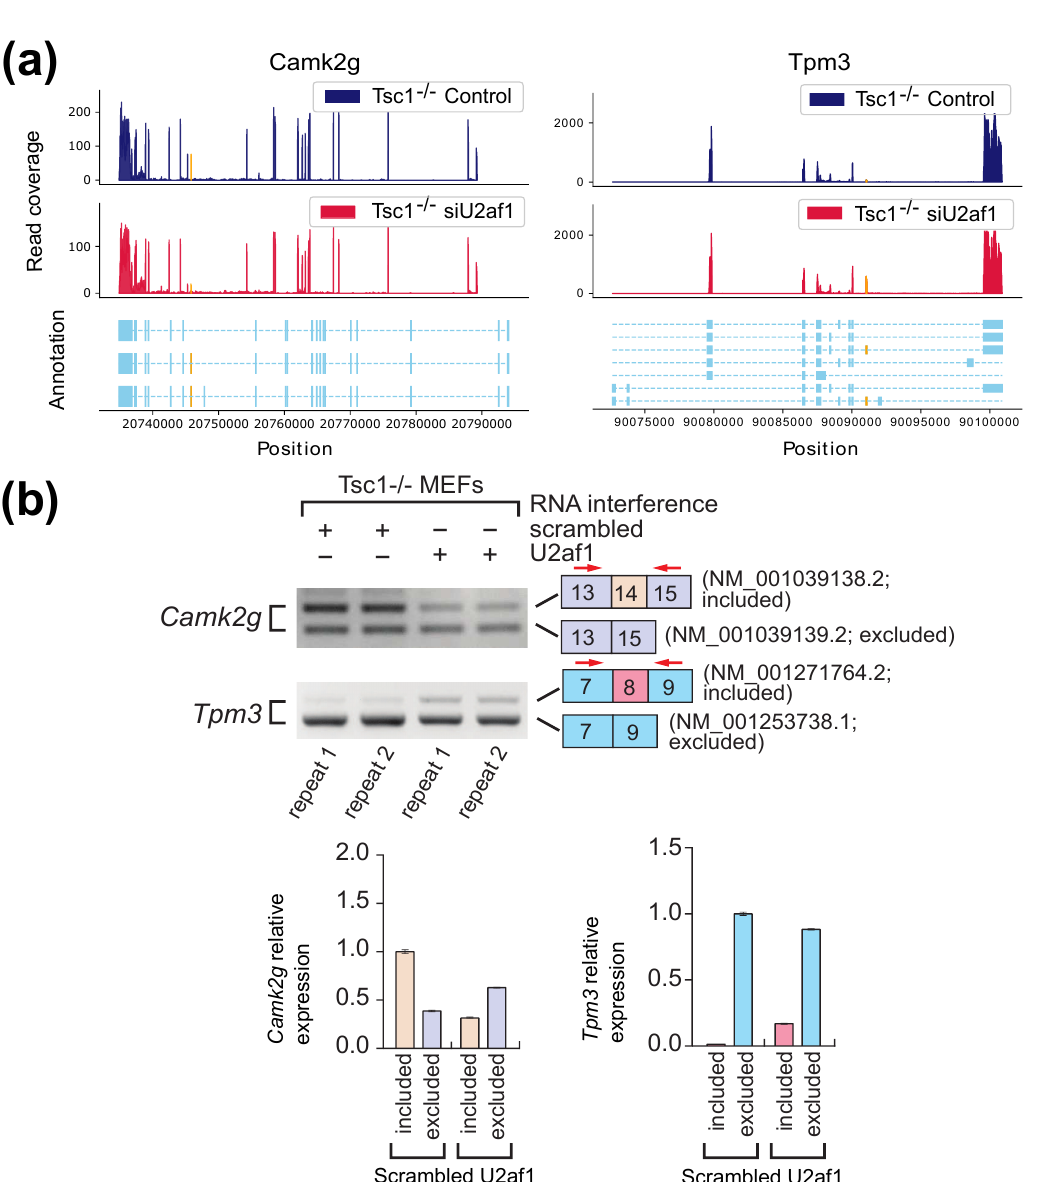
Figure 5. Validation of U2AF1-mediated alternative splicing events that are only detected by AS-Quant ( Camk2g ) or by AS-Quant and SUPPA2 ( Tpm3 ). ( a ) Isoform structures of Camk2g and Tpm3 gene and their RNA-seq read coverage plots. Alternatively spliced exons are marked in yellow. ( b ) Validation of isoform expressions was conducted using RT-PCR and agarose gel electrophoresis. Quantitation of gel images was done using ImageQuant software. Two biological repeats of experiment were performed. Exon inclusion and exclusion are color-coded. Total RNAs from Tsc 1 − / − MEFs used for RNA-Seq experiments were used for RT-PCR amplification of Camk2g or Tpm3 transcript isoforms. Scrambled RNA interference is control and U2af1 RNA interference is the case. The PCR primers to detect transcript isoforms for Camk2g or Tpm3 were marked by red arrows and their sequences are reported in the Supplementary document. Schematic of alternative spliced isoform structures for each PCR product is shown next to the gel image. Exon numbers and transcript identification numbers in RefSeq annotation are shown. A higher band intensity of PCR products indicates a higher expression of that specific transcript